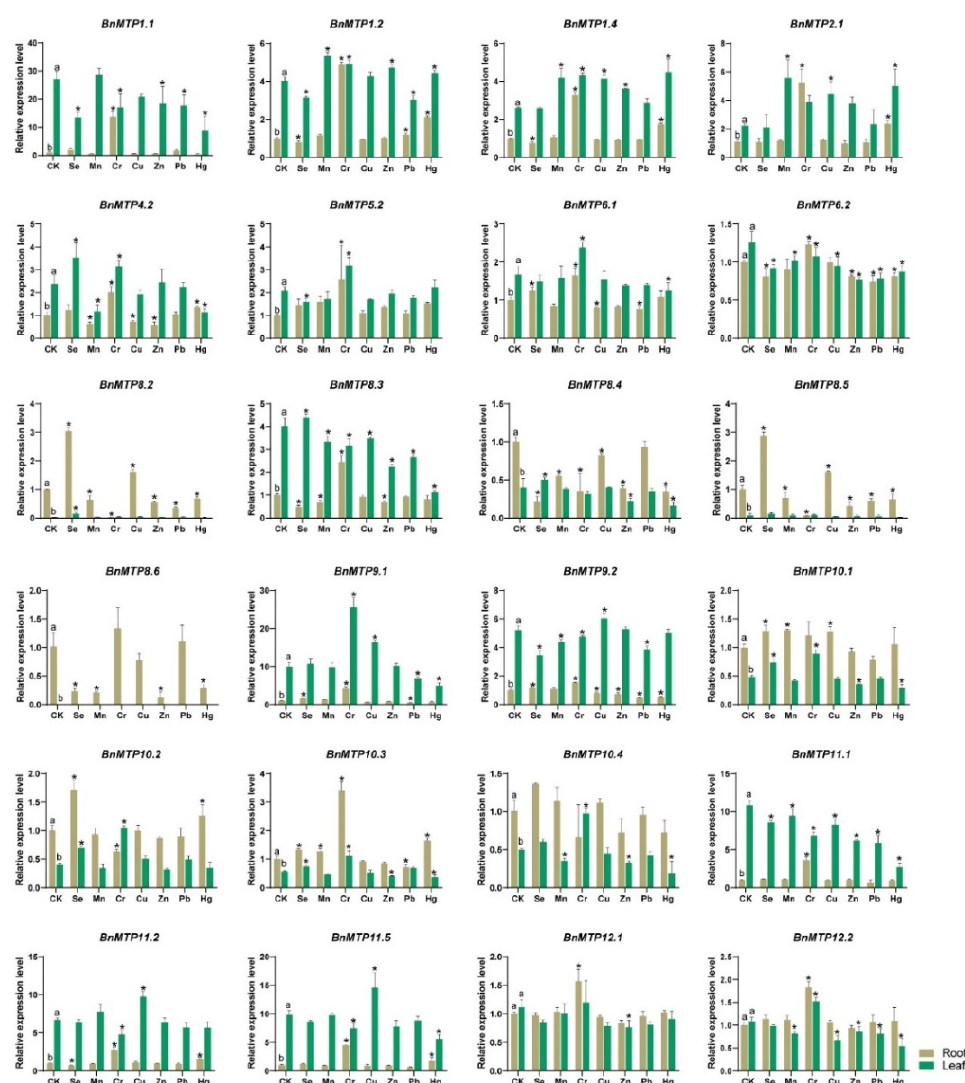
Figure 11. The expression level of BnMTPs under different heavy metal treatments. CK represents the control samples under normal growth conditions. Data represent means ± SD. Different letters (a and b) indicate significant differences between root and leaf under normal conditions. Asterisks indicate significant differences between the treatment samples and CK ( n = 3, p < 0.05).